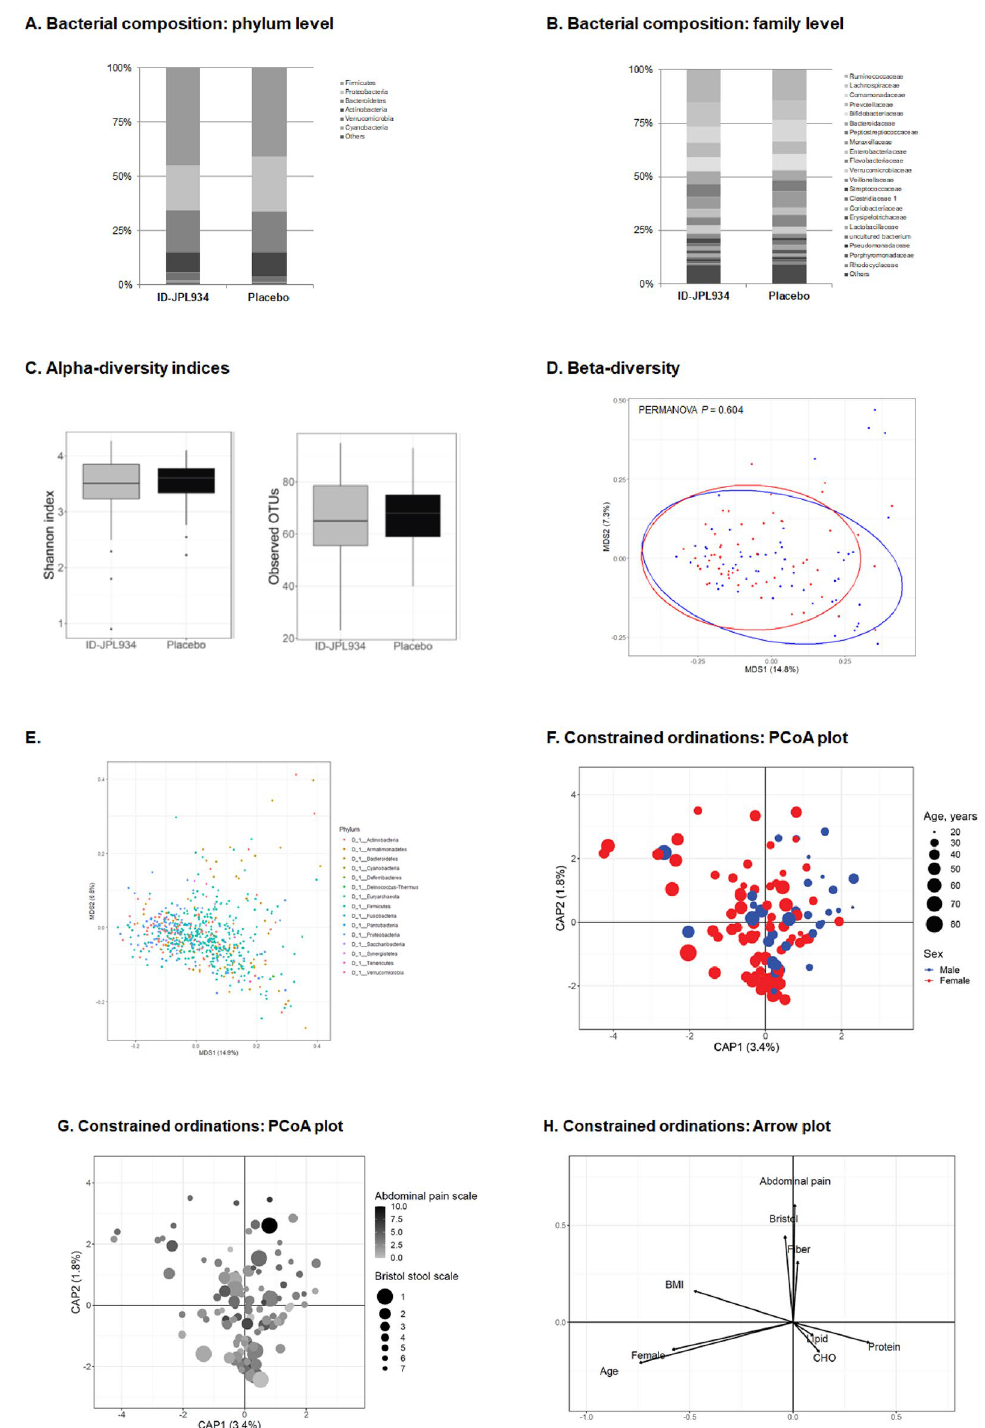
Figure 3. Summary of metagenomic analysis of the microbiome originating from bacteria-derived extracellular vesicles at baseline. The placebo group and the ID-JPL934 group are comparable in bacterial composition at the phylum ( A ) and family levels ( B ). Microbial diversity did not differ between the placebo group and the ID-JPL934 group ( C , p > 0.05). No significant difference in β-diversity index was observed between the two groups (PERMANOVA p > 0.05, Bray–Curtis distance, D ). The figure represents the ordination plot of the OTUs at the phylum level ( E ). Scatter plots of first 2 PC loadings in the canonical analysis of principal coordinates ( F – H ). Arrows indicate components of clinical variables. Some of the clinical variables including stool consistency, sex, age, abdominal pain, and fiber intake appear to correlate with the ordination. CHO, carbohydrate; BMI, body mass